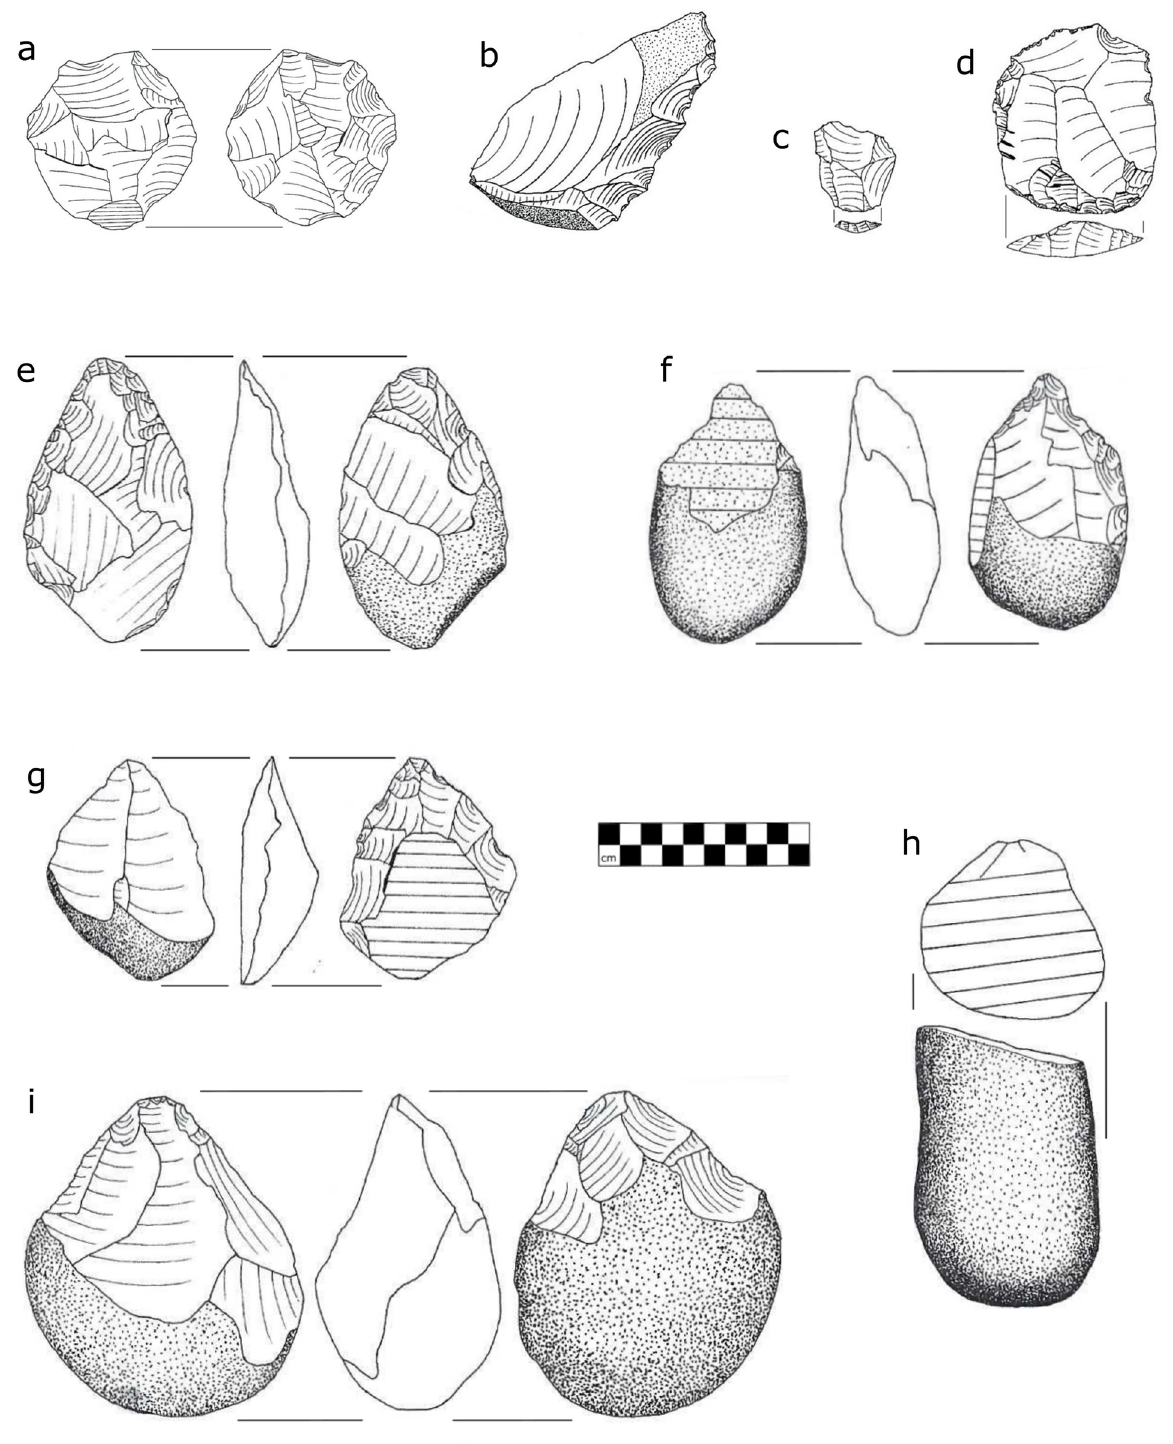
Fig 10. Artefacts from Sitwe localities. a, Radial core (SW23A #25); b, Denticulated side-struck flake (SW23B #333); c, Levallois flake (SW23B #92); d, Levallois cleaver flake (SW23A #135); e, Handaxe (SW23A #181); f, Pick; g, Unifacial handaxe on a split cobble spall (SW60 #43); h, Elongated split cobble (SW23A#130); i, Core-axe (SW23A #127). Scale in cm. Artefacts are conserved at the Livingstone Museum, Plot 567, Mosi-o-tunya Road, Livingstone, Zambia.